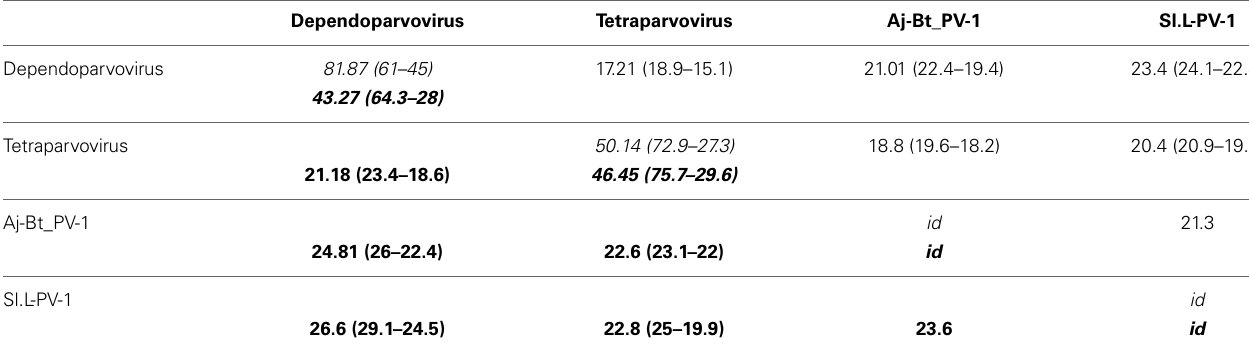
Table 1 | Identities between and within the clades more closely related to Sl.L-PV-1.